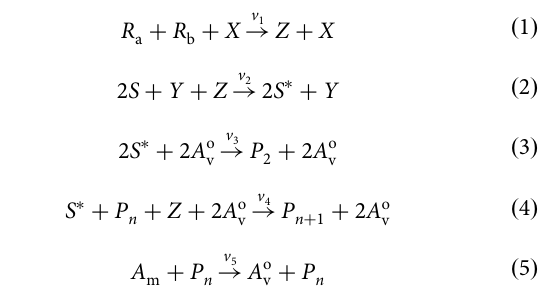
(Fig. 2e). The prolate vesicle elongated with elapse of time by uptake of AOT molecules from the external solution. We shape as axisymmetric prolate shape. The time evolution of the surface area, A ( t ), for the optimised cascade reaction conditions is plotted as red circles in Fig. 3b, where the vesicle surface area is normalised by the surface area of the initially spherical vesicle, A (0). This experiment was carried out six times, each time using a different vesicle sample. The target vesicles showed exponential growth, although the growth rate was almost half compared with that triggered by the direct addition of H 2 O 2 in the absence of D-glucose and GOD (Supplementary Note 2-2). For reference,